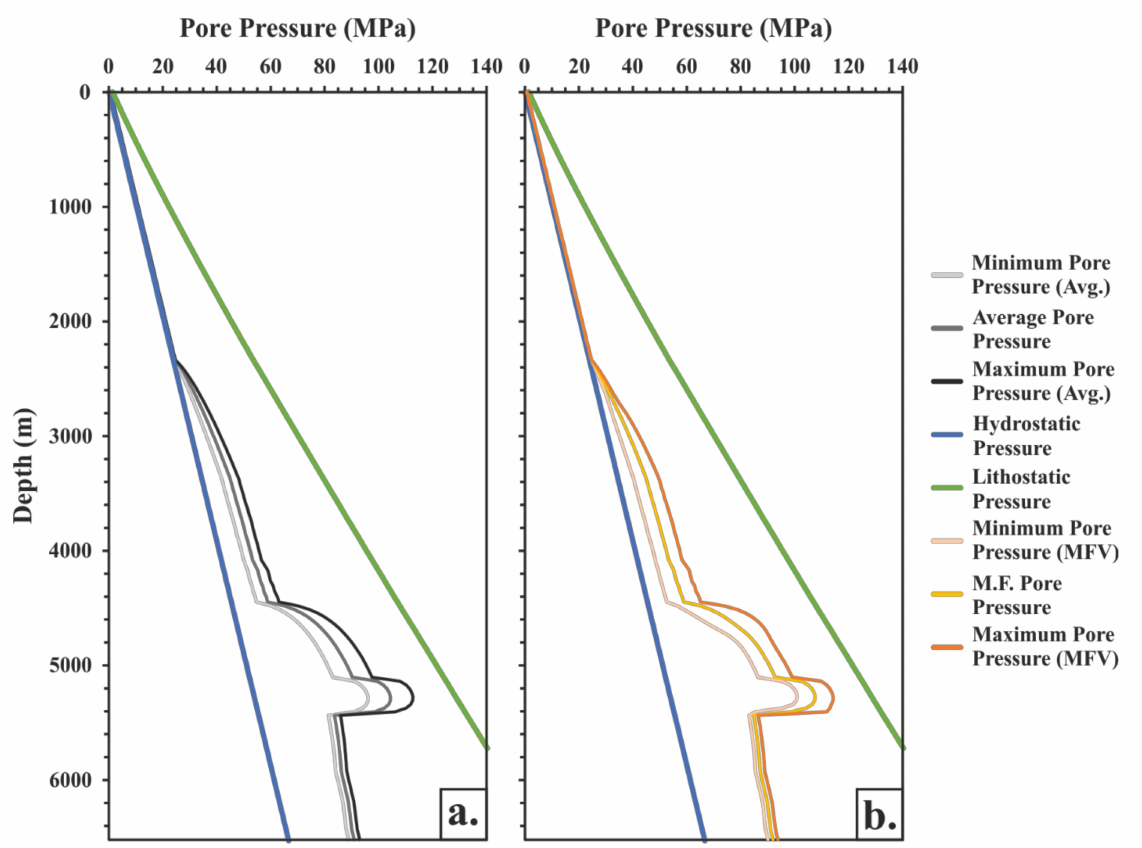
Figure 13. Predicted stochastic pore pressure-depth plots at the middle of the deepest point of Section_01: ( a ) predicted minimum, maximum, and average pore pressure; ( b ) minimum, maximum, and the most frequent pore